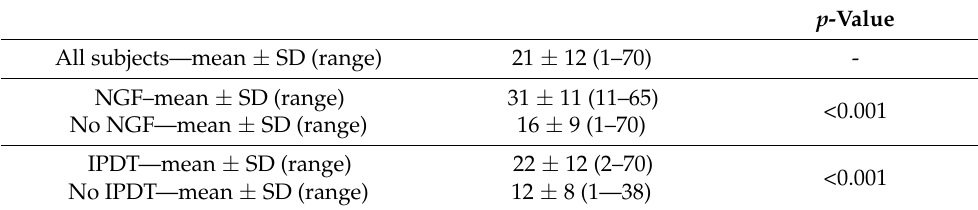
Table 5. Mean days of hospitalisation (effects of NGF and IPDT).